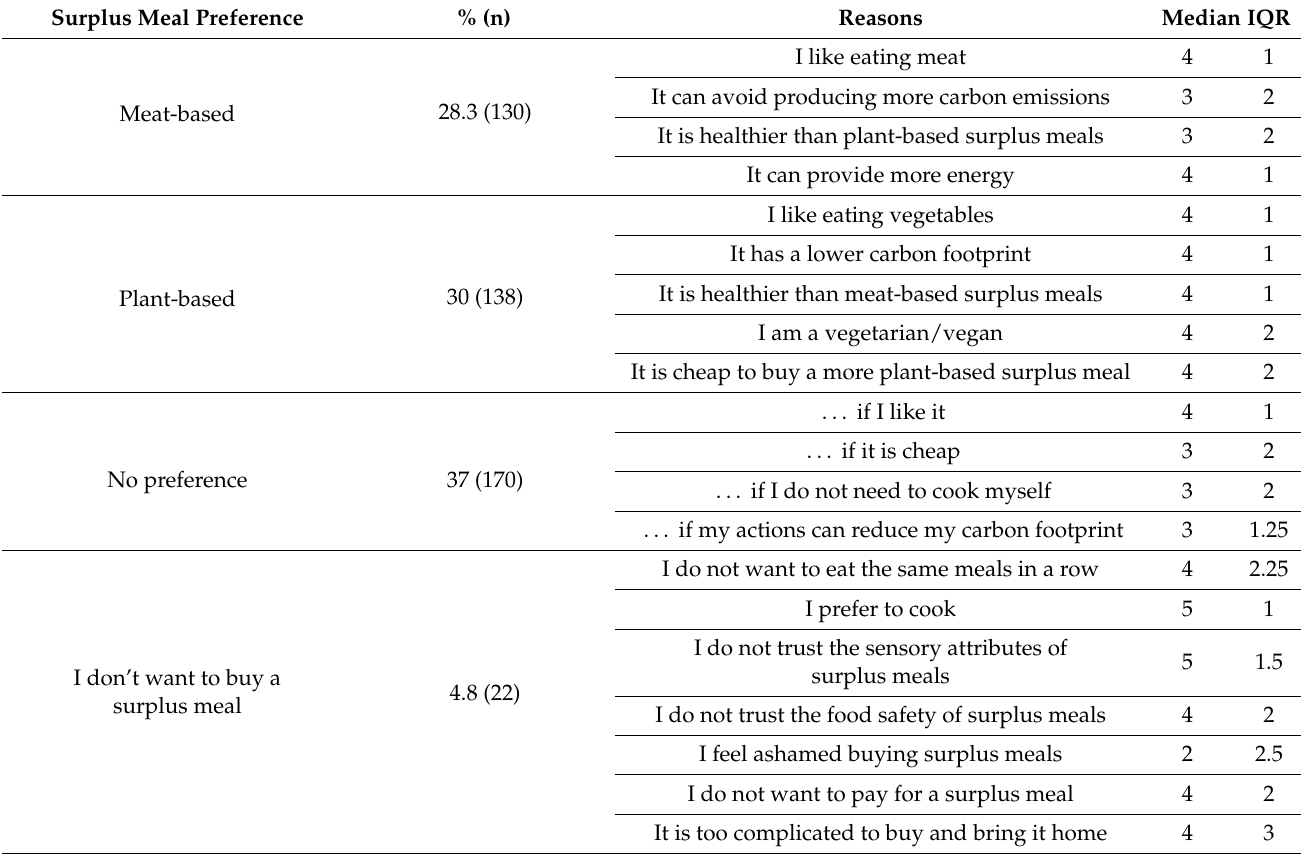
Table 4. The respondent’s buying preferences towards surplus meal types and the reasons, N = 460.